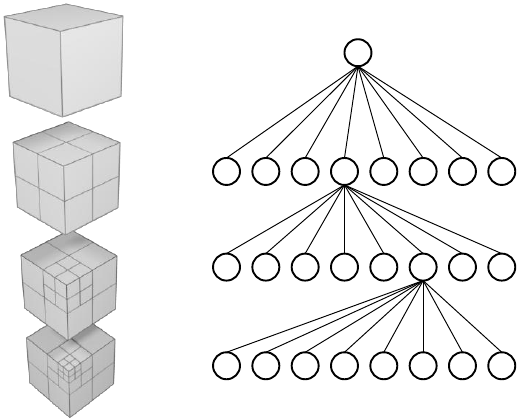
Figure 5: Core concept of the octree approach. The initial cube is recursively divided into further 8 sub-cubes until a predefined termination condition.